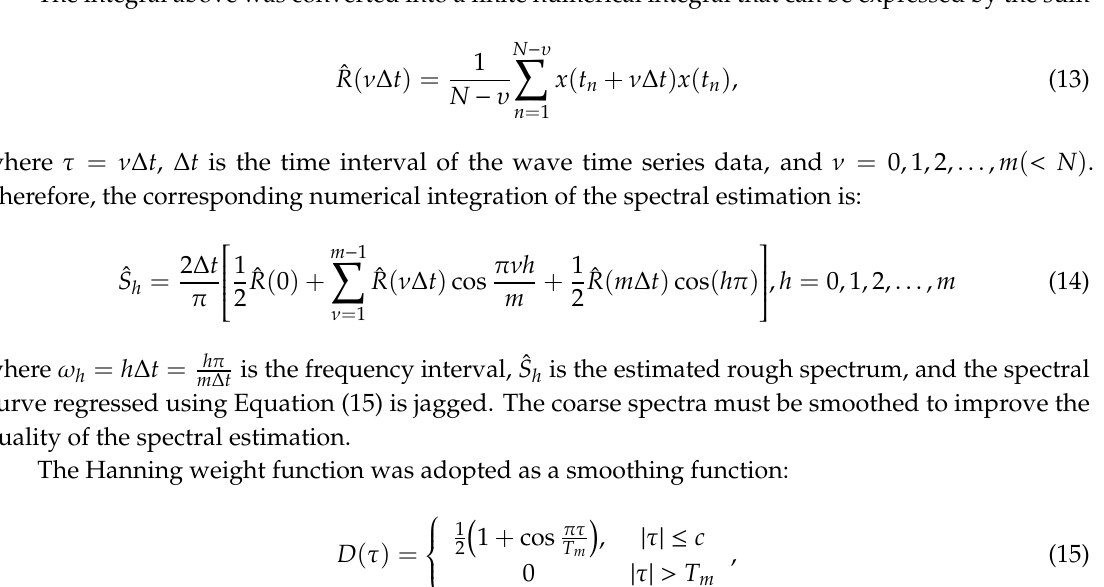
Figure 7. Real-time wave data simulated using radar spectra for ( a ) H s = 1.0583 m and ( b ) H s = 0.6069 m. Table 2. Summary of observation statistics.